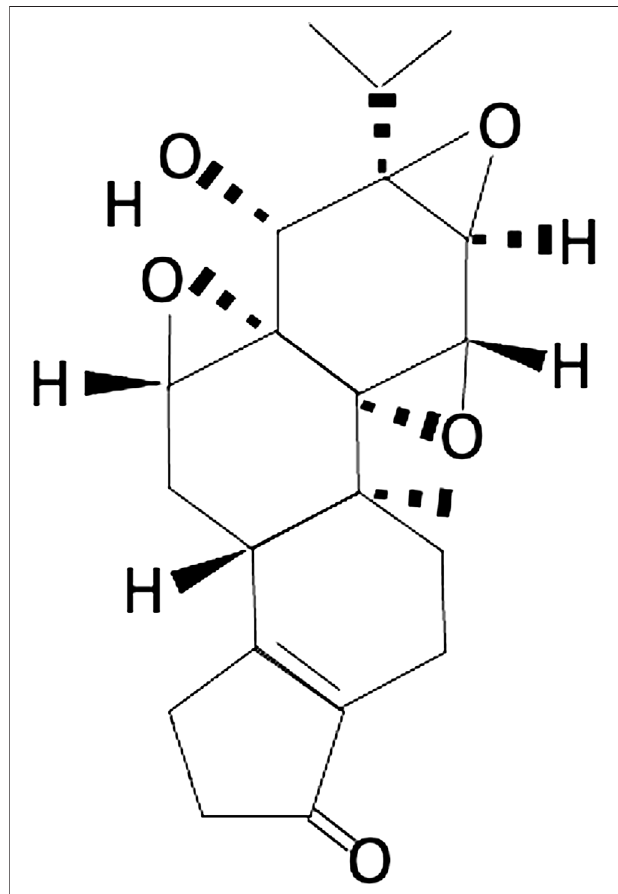
FIGURE1| Chemicalstructureoftriptolide:triptolidehasbeenshownto possess a broad spectrum of anti-in fl ammatory, anti-immunosuppressive, and anti-oxidative properties in treating various